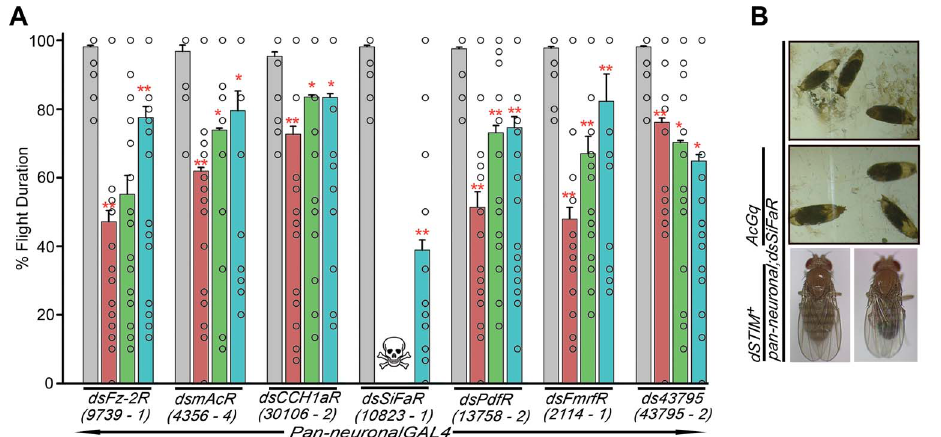
Figure 3. G-protein coupled receptors that regulate flight in Drosophila through IP 3 R mediated Ca 2 + signaling. A ) Percentage flight times are shown. The bars represent RNAi heterozygotes (grey), pan-neuronal RNAi knockdown (red), pan-neuronal RNAi knockdown plus AcGq (green) and pan-neuronal knockdown plus dSTIM + (blue). Mean flight times ( 6 SEM) were obtained by measuring tethered flight in three batches of 10 tethered flies of each genotype after an air-puff stimulus. Open circles within the bars indicate percentage flight times for each fly. Pan-neuronal knockdown of GPCRs (red) was compared to pan-neuronal GAL4 controls (grey) and the rescues (blue, green) were compared to the knockdown (red; *P , 0.05, one-way ANOVA). B ) Pan-neuronal knockdown of the SiFamide receptor ( 10823-1 ) results in pupal lethality (shown as a skull in A). Lethality was suppressed by pan-neuronal over-expression of dSTIM + but not AcGq .